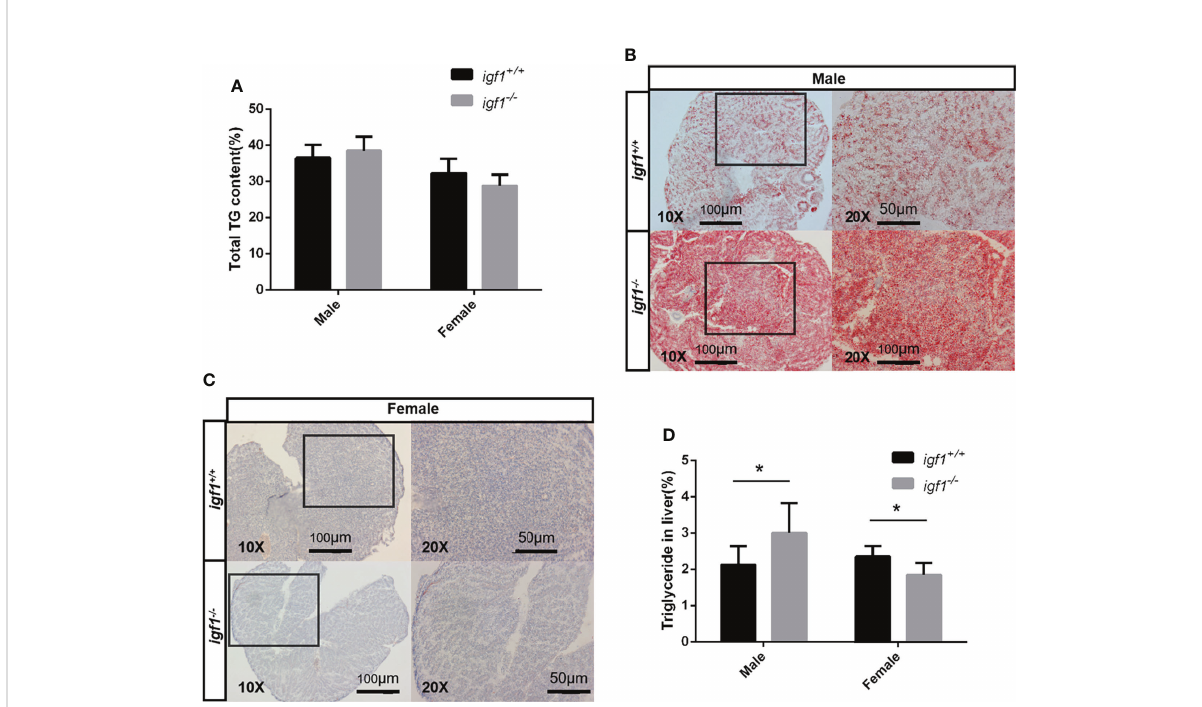
FIGURE 5 Hepatic steatosis observed in igf1 -de fi cient male fi sh. (A) Body fat composition of igf1 -de fi cient and wildtype control. (B, C) Frozen section and oil-red O staining of the hepatic tissue. Lower magni fi cation images are shown at 10X, higher magni fi cation of the indicated regions is shown at 20X. (D) Triglyceride content of the hepatic organ of igf1 -de fi cient fi sh compared to controls (n = 6/group). * P <